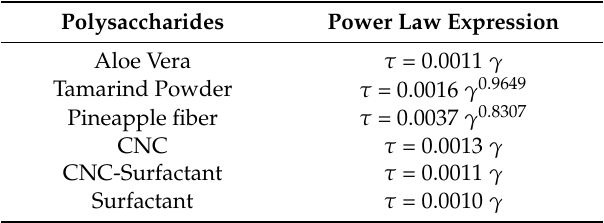
Table 1. Power law model expression for different